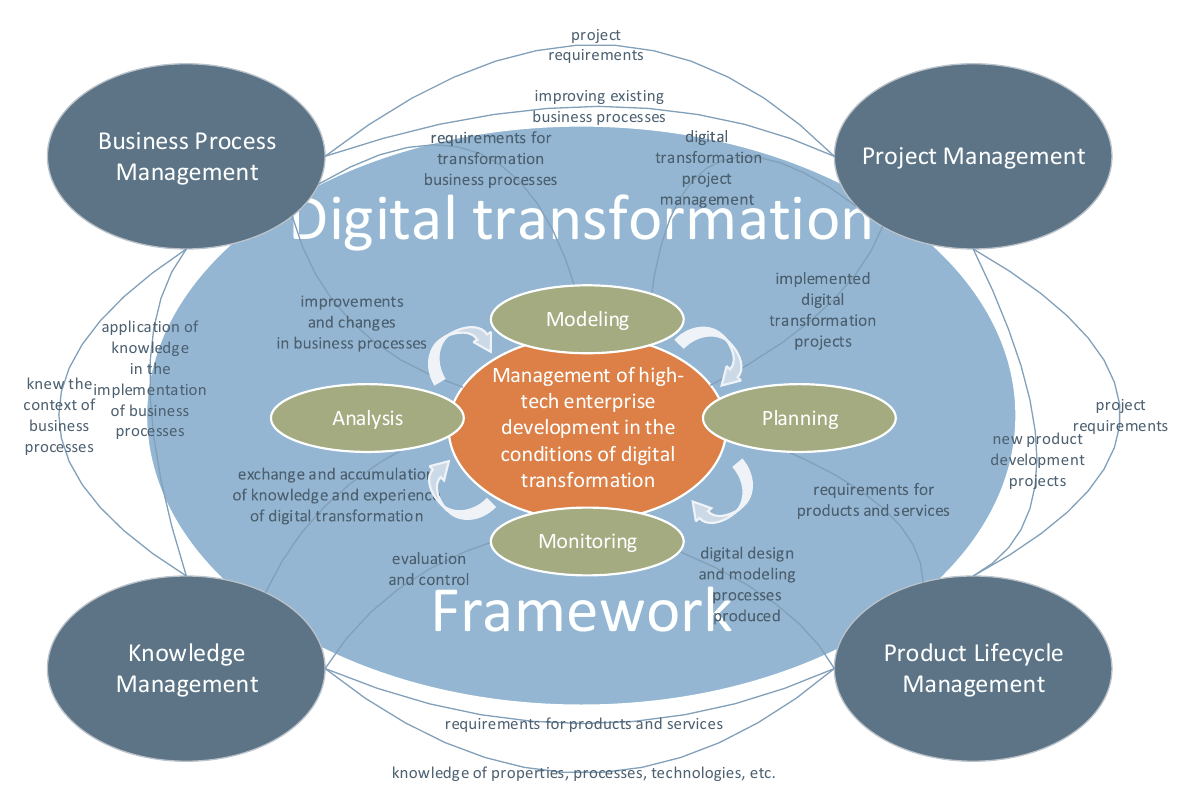
Figure 3. The digital transformation framework in the enterprise. Source: own study.